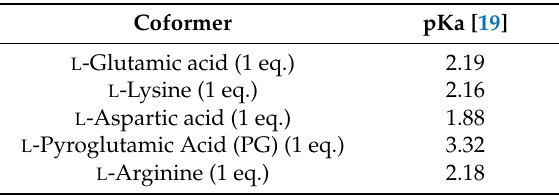
Table 1. Amino acids used as coformer and their